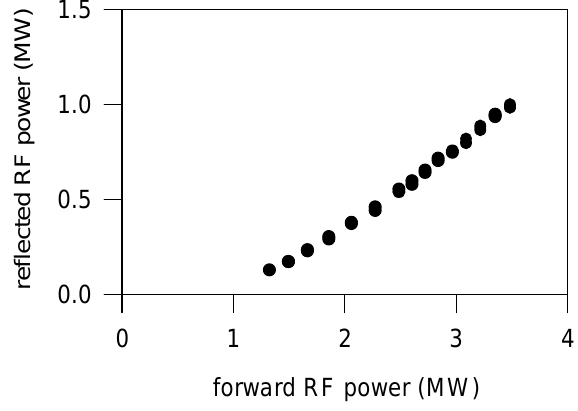
FIG. 5. RF power reflected from the drive gun as a function of the power sent to the gun (forward).